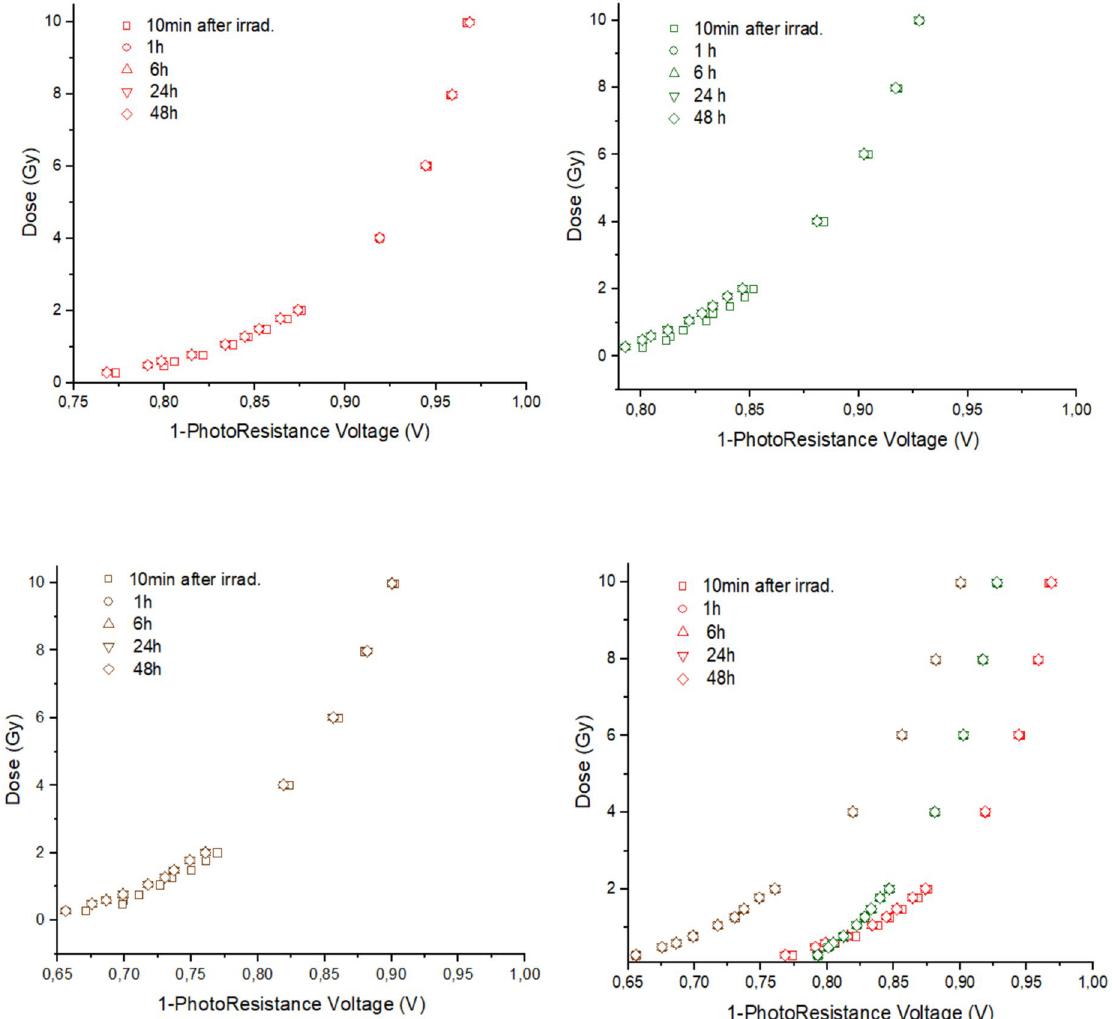
Figure 5. Photo-resistive voltage obtained for each light over time from all the irradiated samples with delivered doses from 0.25 to 10 Gy. From top-left to bottom-right: red, green, both red and green, and all channels